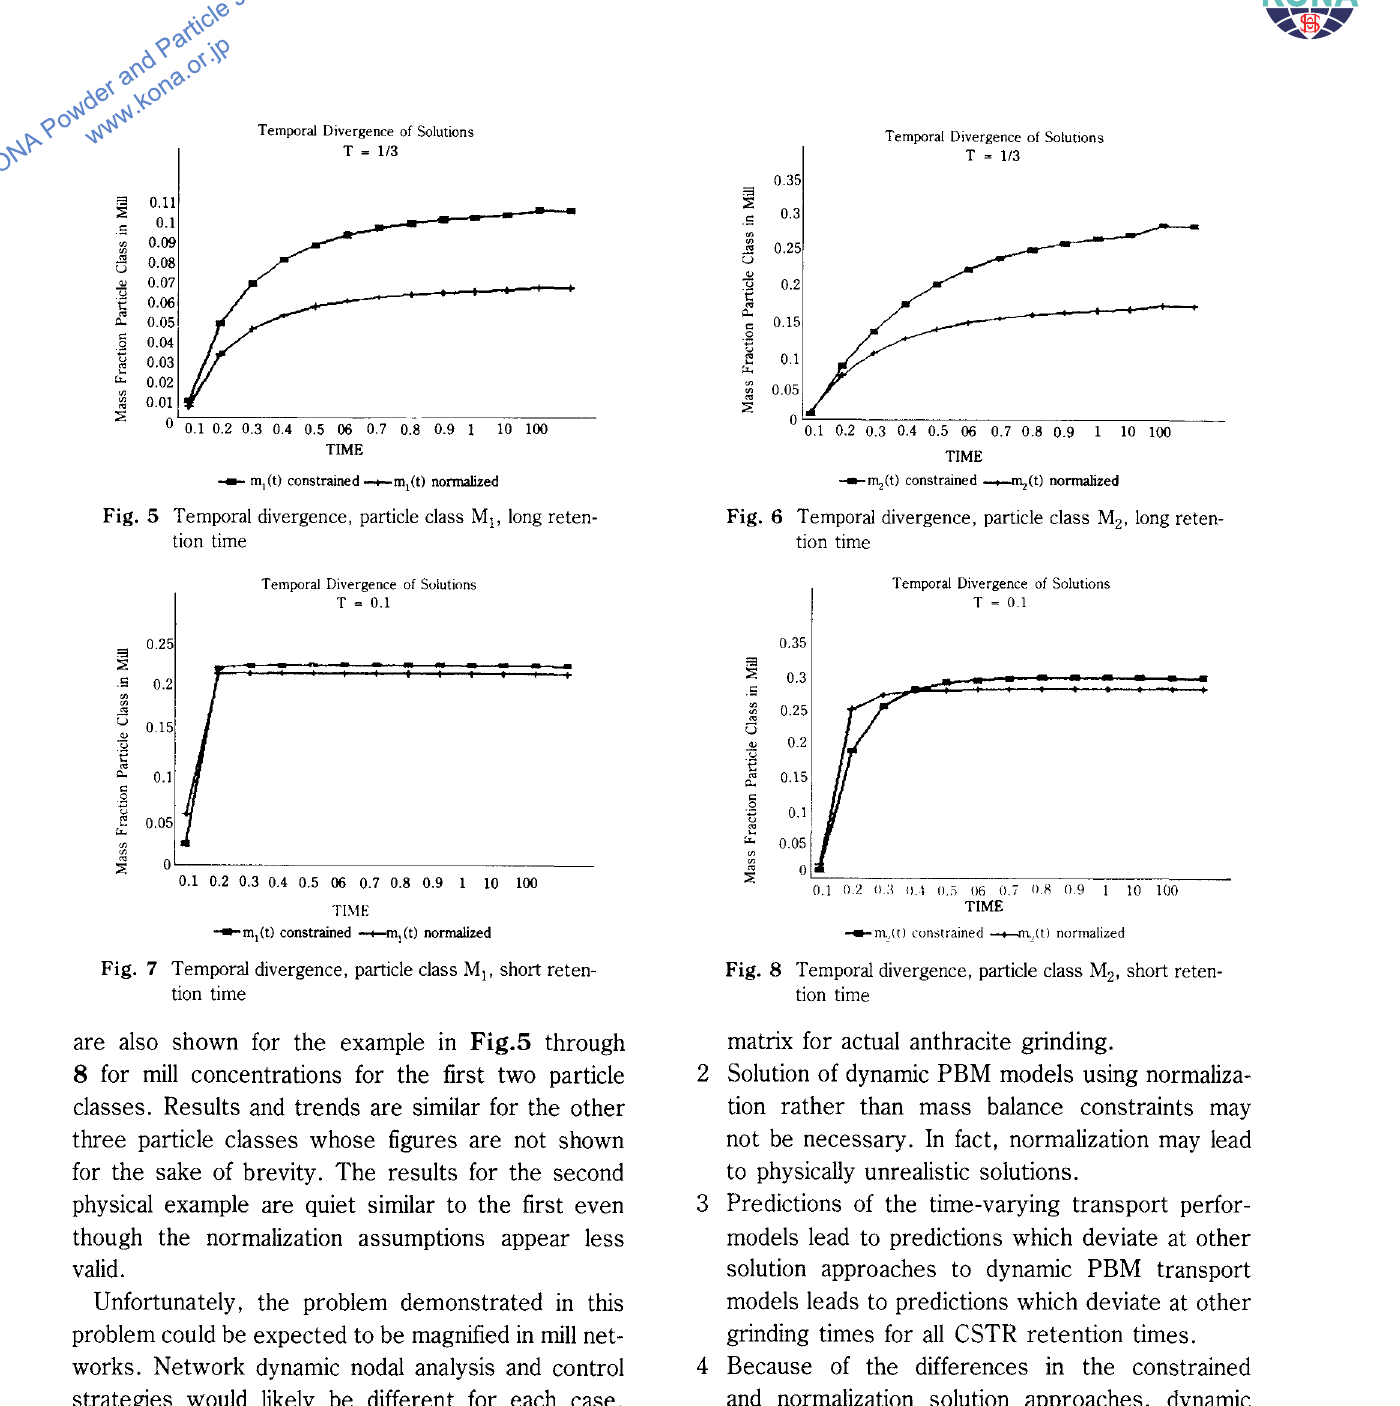
Fig. 7 Temporal divergence, particle class M 1, short reten tion time